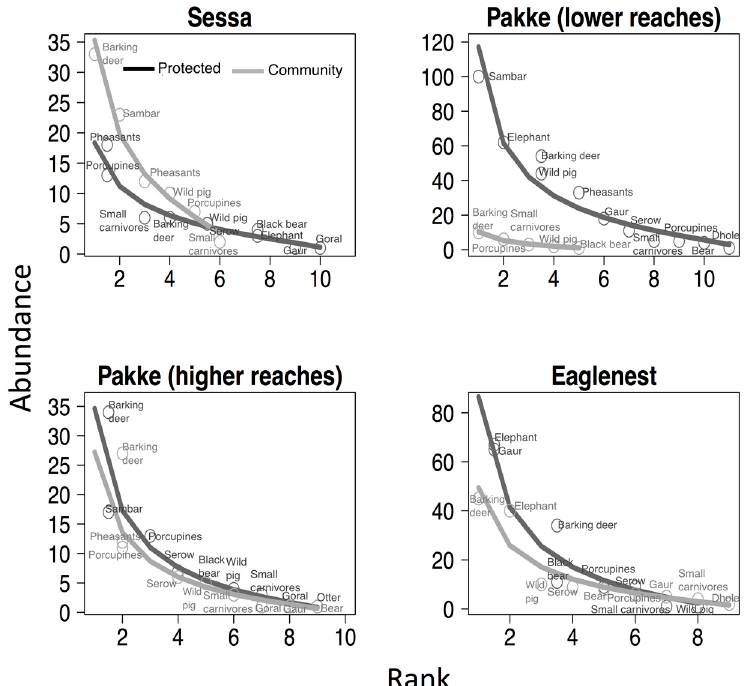
Figure 3. Plots showing species evenness in protected areas and community-managed lands. Species rank abundance distribution plots are fitted with lognormal models. Lines and points are trends and species occurrences in protected areas (dark grey) and community-managed lands (light grey). Protected areas of Sessa and Pakke’s lower reaches had higher evenness than their community-managed lands.